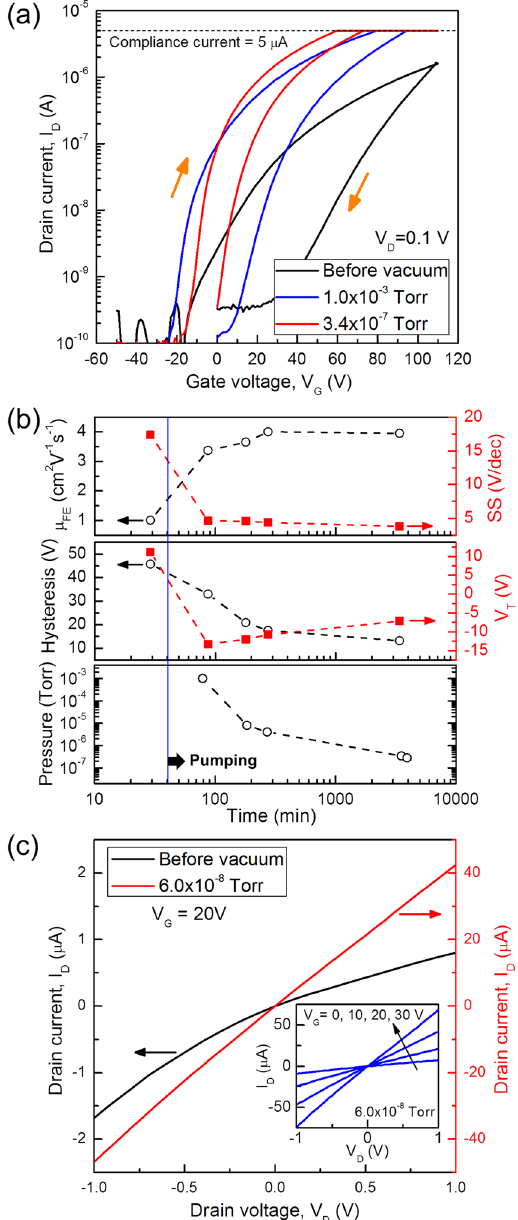
Figure 2. Dependence of the electrical characteristics of the monolayer MoS 2 FETs on ambient pressure. ( a ) Drain current ( I D ) of the monolayer MoS 2 FET as a function of gate voltage ( V G ) under a constant drain voltage ( V D ) of 0.1 V with different ambient pressure from atmospheric pressure to 1.0 × 10 − 3 Torr and 3.4 × 10 − 7 Torr. The drain current of the device is measured inside a vacuum probe station as the gate voltage is swept from − 50 V to 110 V and then back to 0 V with the sweeping direction indicated by orange arrows and the sweeping rate at 5 V/s. We set the compliance current to 5 μ A for the drain current to improve the measurement resolution near the subthreshold regime. ( b ) Continuous measurement of electrical parameters as the pressure is gradually lowered from ambient to 3.4 × 10 − 7 Torr: hysteresis, threshold voltage ( V T ), field-effect mobility ( μ FE ), and subthreshold swing ( SS ) – defined in the main text. A non-monotonic dependence of threshold voltage on pressure is observed in the graph of V T vs. time (middle panel). The dashed lines through the data points are guides to the eye. ( c ) The I D − V D characteristics of the monolayer MoS 2 FET before and after vacuum (6.0 × 10 − 8 Torr). Inset: output characteristics of the MoS 2 device under vacuum with various gate voltages. The linear I D − V D characteristics indicate that the contact is